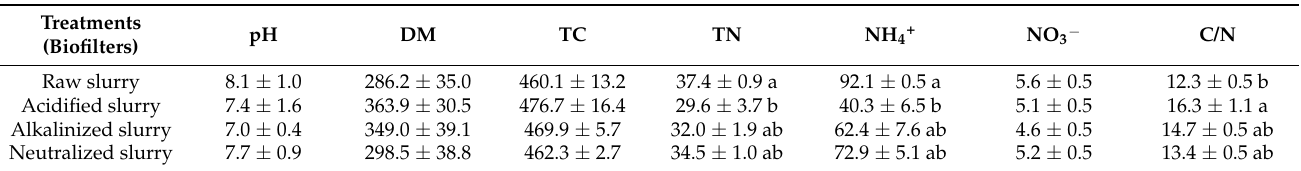
Table 3. Physicochemical characteristics of the biofilter of each treatment at the end of the experiment (mean ± standard deviation) ( n =